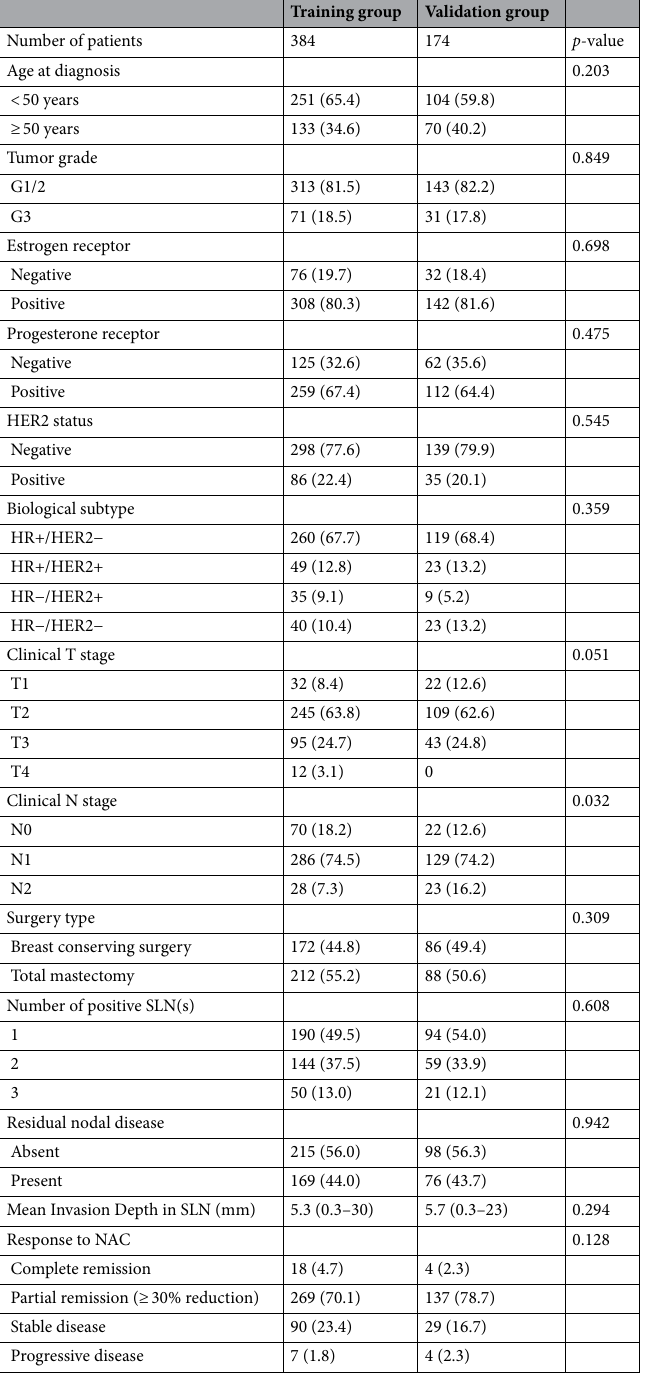
Table 2. Comparison of the training group and validation group. SLN (Sentinel Lymph Node). NAC (Neoadjuvant chemotherapy). Response to NAC: followed the Revised Response Evaluation in Solid Tumors (RECIST) guideline, version